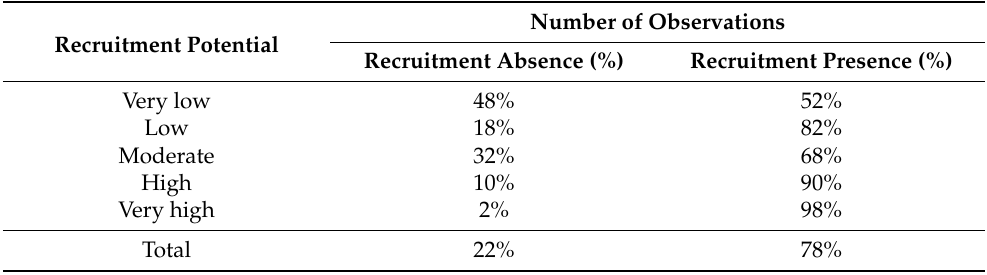
Table 5. Results from a survey using Google Street View to record the presence and absence of Eucalyptus globulus recruitment in 250 random locations inside Natura 2000 sites stratified according to classes of recruitment potential (50 observations in each class).